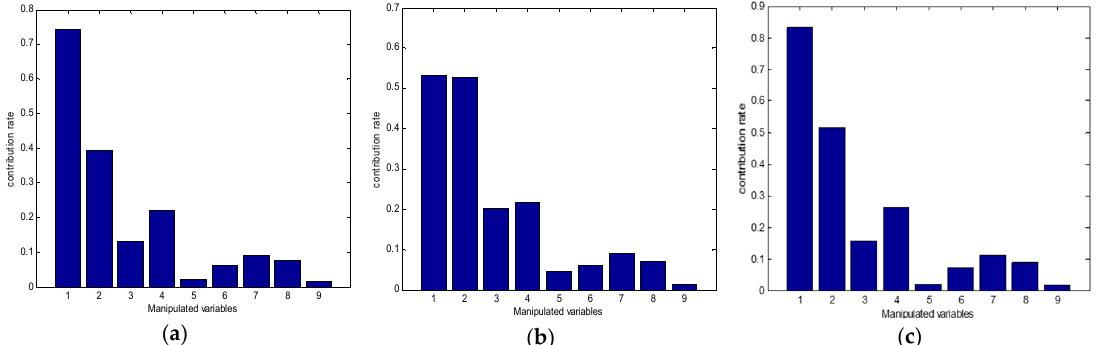
Figure 10. Nonoptimal performance cause identification result. ( a ) “General” grade nonoptimal cause identification; ( b ) “poor” grade nonoptimal cause identification; ( c ) “good” grade nonoptimal cause